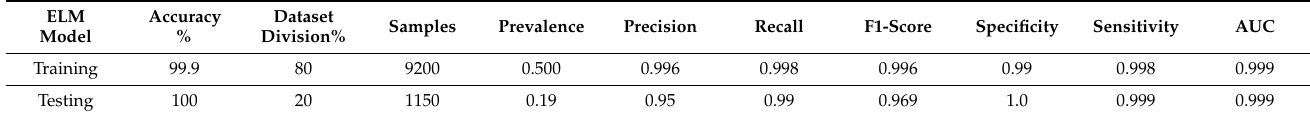
Table 4. ELM Performance Parameters of Experiment # 1.